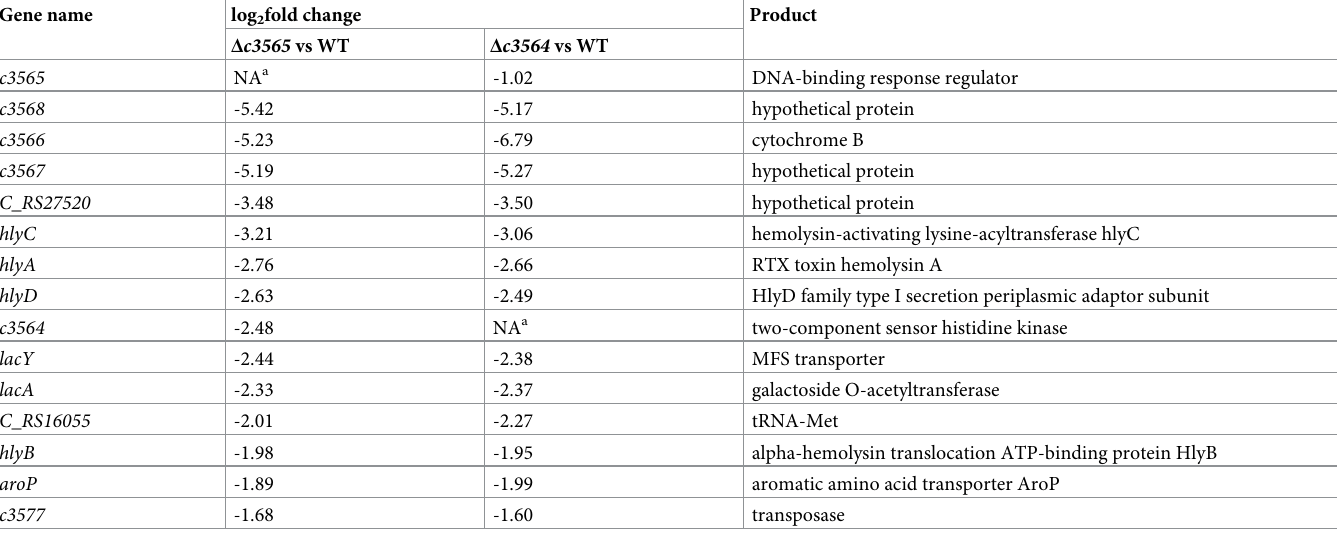
Table 1. Select genes that were differentially expressed in the Δ c3564 and Δ c3565 mutants compared to the wild